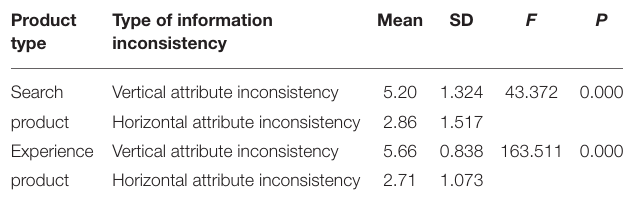
TABLE 1 | Manipulation check of type of information inconsistency.